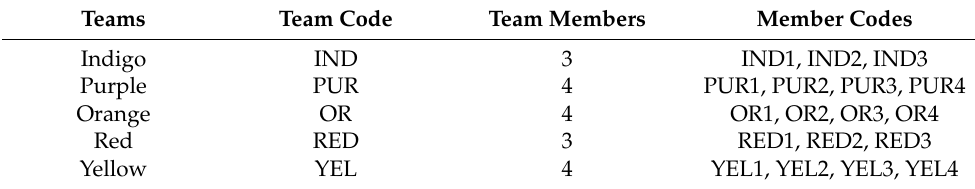
Table 1. Team composition and